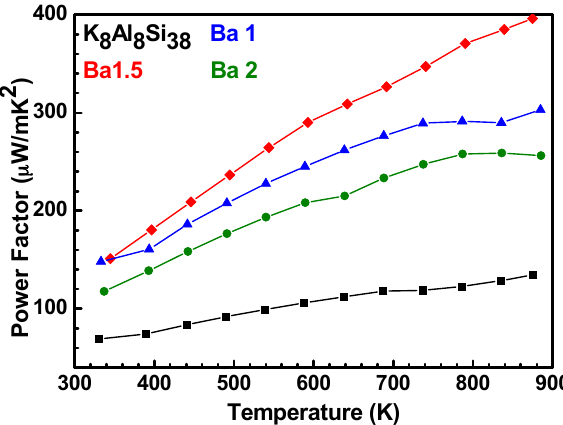
Figure 7. Thermoelectric power factors (S 2 σ ) for K 8-x Ba x Al 8+x Si 38-x (x = 0, 1, 1.5, 2) samples from 323 K to 873 K. Adapted with permission from Sui, F.; Kauzlarich, S.M. Tuning Thermoelectric Properties of Type I Clathrate K 8-x Ba x Al 8+x Si 38-x through Barium Substitution. Chem. Mat. 2016 , 28 , 3099–3107 [37].